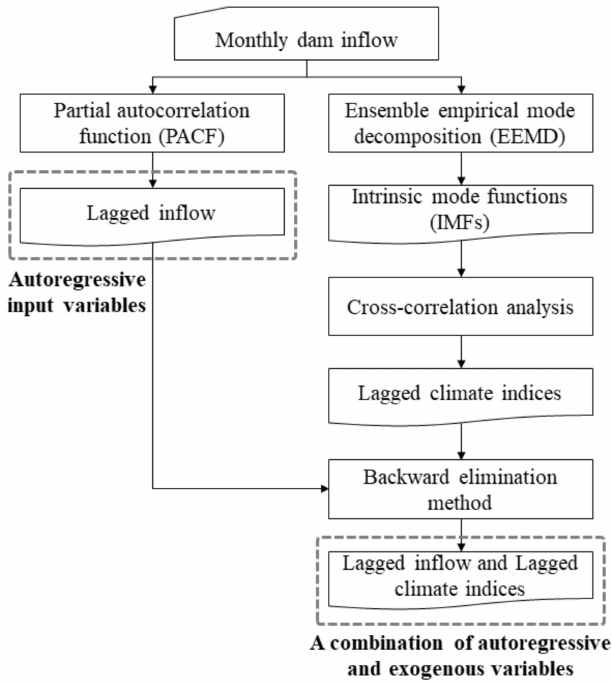
Figure 5. Procedure to select the two types of input variables: (1) Autoregressive variables (AR-); (2) a combination of autoregressive and exogenous variables